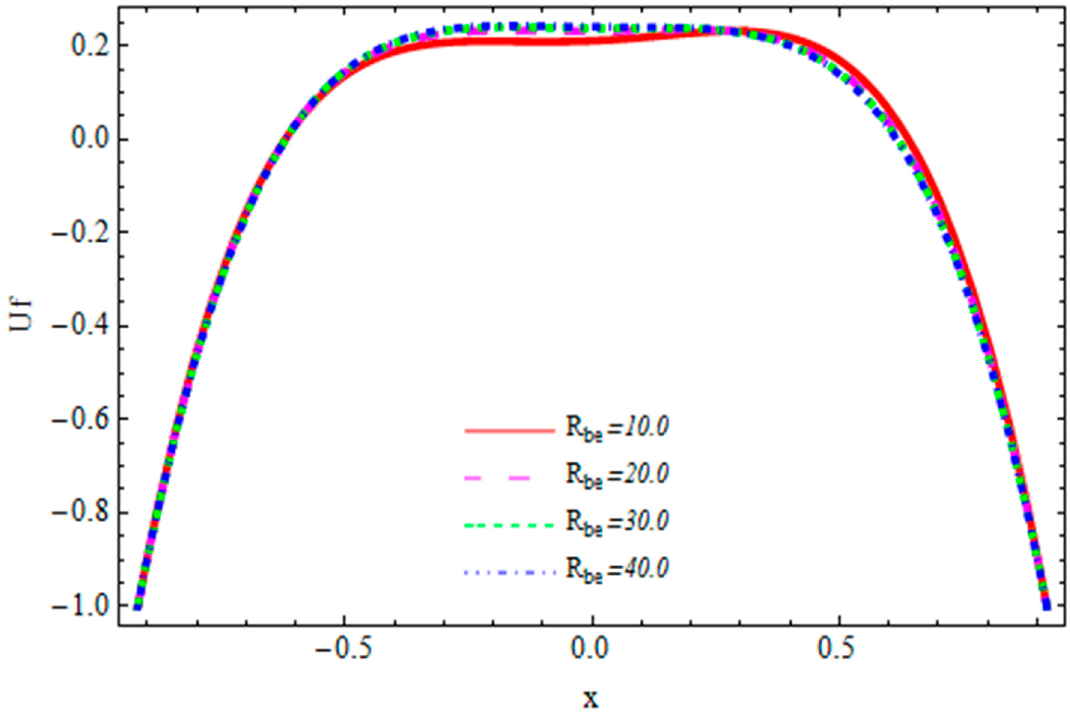
Figure 11. Fluid velocity curves for several values of R (cid:2912)(cid:2915) . 𝐶 (cid:3028)(cid:3040) = 1.0,𝐸 (cid:3042) = 1.0,𝐶 (cid:3039) = 10, 𝑉 (cid:3029) = 1.0, 𝑊 (cid:3046) = 10, and 𝐶 (cid:3050) = 1.0.